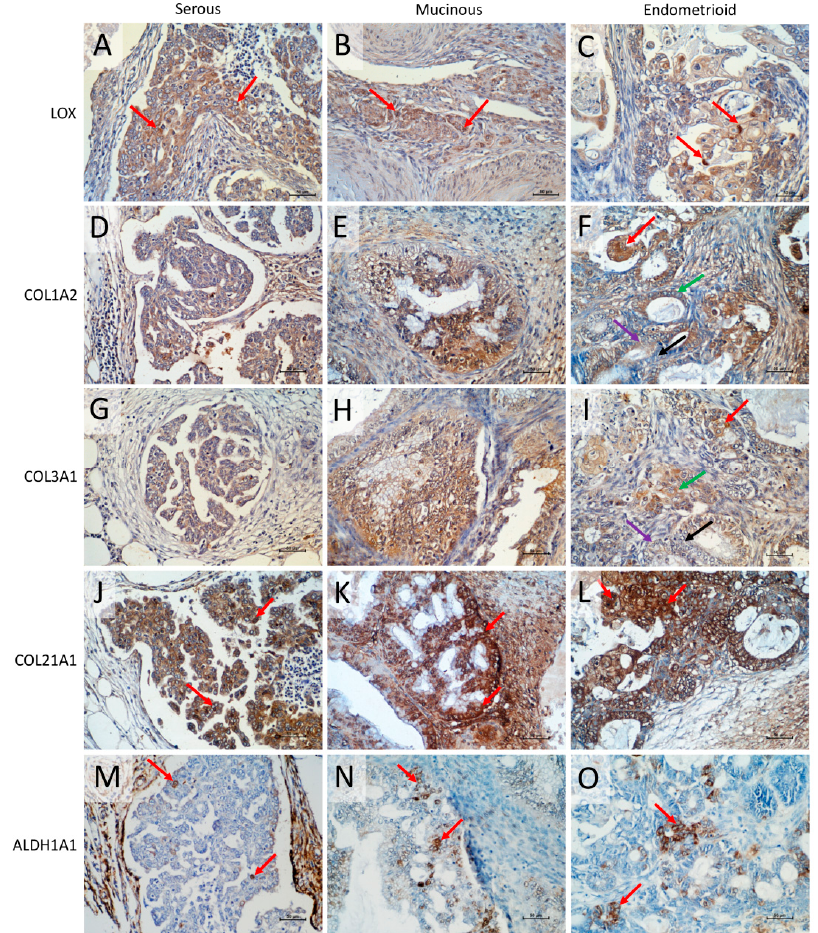
Figure 9. Immunohistochemical expression of (1) LOX in serous adenocarcinoma ( A ), mucinous ovarian cancer ( B ), and endometrioid adenocarcinoma ( C ), strong cellular LOX expression illustrated by red arrows; (2) COL1A2 in cancer cells of serous adenocarcinoma (moderate intensity score) ( D ), mucinous ovarian cancer (strong intensity score) ( E ), and endometrioid adenocarcinoma: cells with high intensity score (red arrow), cells with moderate intensity score (green arrow), cells with mild intensity score (purple arrow), and cells with no COL1A2 expression (black arrow) ( F ); (3) COL3A1 in cancer cells of serous adenocarcinoma (moderate intensity score) ( G ), mucinous ovarian cancer (strong intensity score), ( H ) and endometrioid adenocarcinoma: cells with high intensity score (red arrow), cells with moderate intensity score (green arrow), cells with mild intensity score (purple arrow), and cells with no COL1A2 expression (black arrow) ( I ); (4) COL21A1 in cancer cells of serous ( J ), mucinous ( K ), and endometrioid ( L ) carcinoma: cells with stronger expression illustrated by red arrows; (5) ALDH1A1 in serous adenocarcinoma ( M ), mucinous ovarian cancer ( N ) and endometrioid adenocarcinoma ( O ), strong cellular ALDH1A1 expression illustrated by red arrows. Sections were counterstained with hematoxylin. Scale bar = 50 μ m.